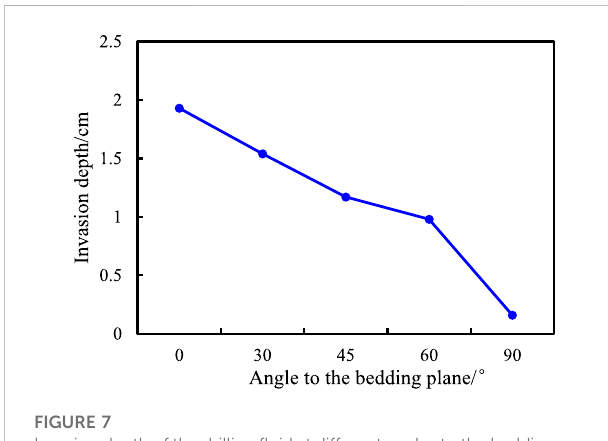
FIGURE 8 Invasion depth of the drilling fl uid at different viscosities of the drilling fl